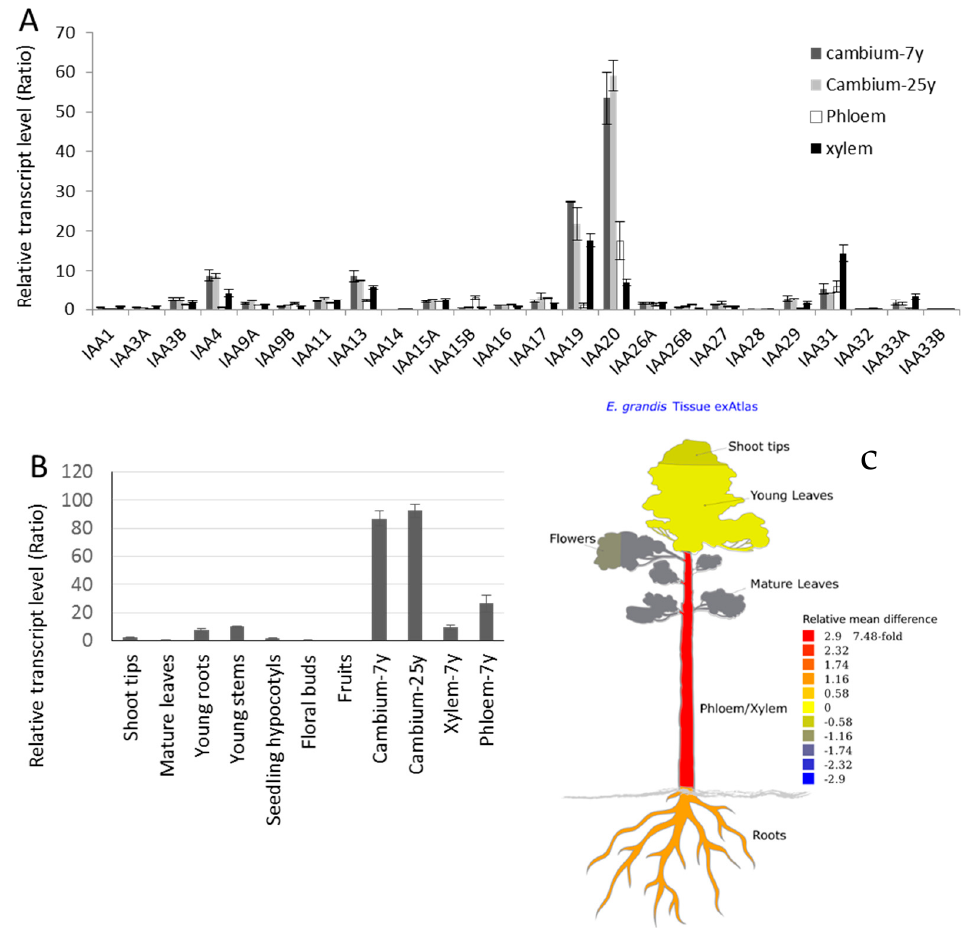
Figure 1. EgrIAA20 transcript ( Eucgr.K00561 ) shows preferential accumulation in the cambium of Eucalyptus . ( A ) Ratio of relative mRNA abundance of all Eucalyptus Aux / IAA members in vascular tissues including: juvenile vascular cambium (Cabium-7-year-old tree), mature vascular cambium (Cambium-25-year-old tree), phloem (7-year-old tree), and xylem (7-year-old tree). ( B ) Real-time PCR expression levels of EgrIAA20 in various Eucalyptus tissues and organs. Each relative mRNA abundance was normalized to a control sample (in vitro Eucalyptus plantlets). Error bars indicate mean expression values ±SE from three independent experiments. ( C ) Pictographic view of EgrIAA20 expression across a diverse range of RNAseq expression datasets by exImage (https://eucgenie.org/exImage, accessed on 25 April 2022).